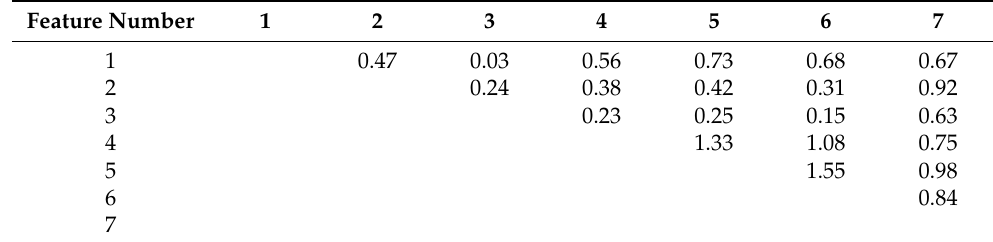
Table 2. φ 2 statistic